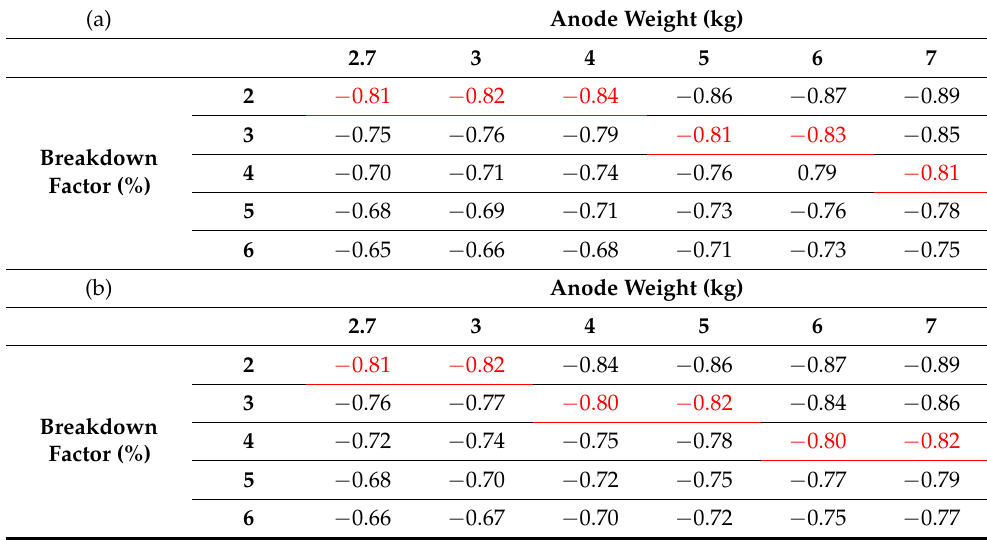
Figure 9. ( a ) Simulation of potential distribution on panel A with a 7 kg anode and coating defects equivalent to a fc = 2%. ( b , c ) Evaluation of potential distribution with fc = 3% considering an increase in ( b ) defect size or ( c ) defect concentration. Table 4. Minimum protection potential obtained as a function of anode weight and breakdown factor: (a) keeping constant the number of defects and increasing their size, (b) keeping constant the size of defects and increasing their concentration. Below the red line the overpotential hull does not guarantee a complete